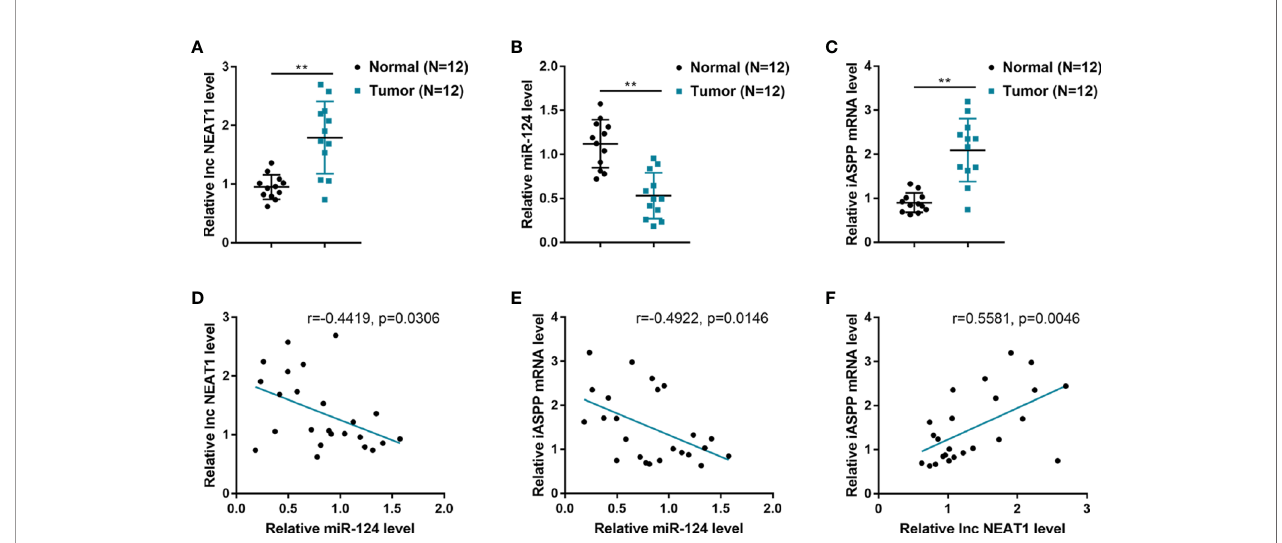
FIGURE 4 | Expression and correlation of NEAT1, miR-124, and iASPP in human CRC tissue samples. (A – C) The expression of lncRNA NEAT1, miR-124, and iASPP were determined in 12 paired of CRC and adjacent non-cancerous tissues by qRT-PCR. ** P < 0.01. (D – F) The correlation of lncRNA NEAT1, miR-124, and iASPP expression in tissue samples was analyzed by Pearson ’ s correlation